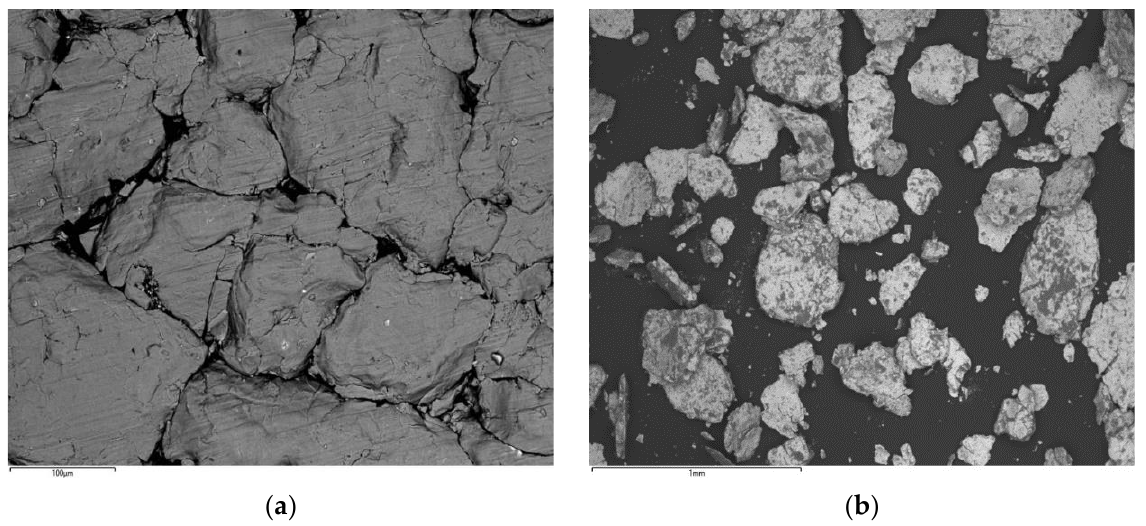
Figure 2 . Backscattered electron micrographs of ( a ) one-time cold-rolled Ti 16 V 60 Cr 24 alloy; ( b ) 5-minute ball-milled Ti 16 V 60 Cr 24 alloy.